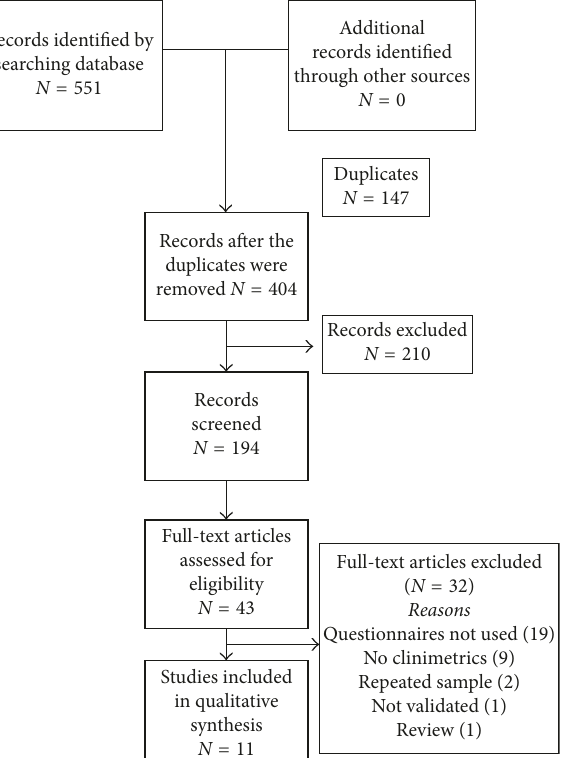
Figure 1: Flow diagram for data